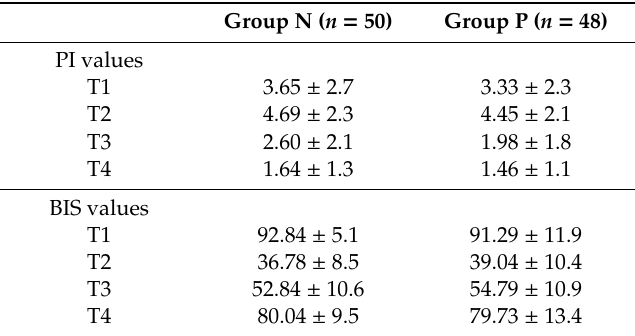
Table 4. Perfusion index and bispectral index values over